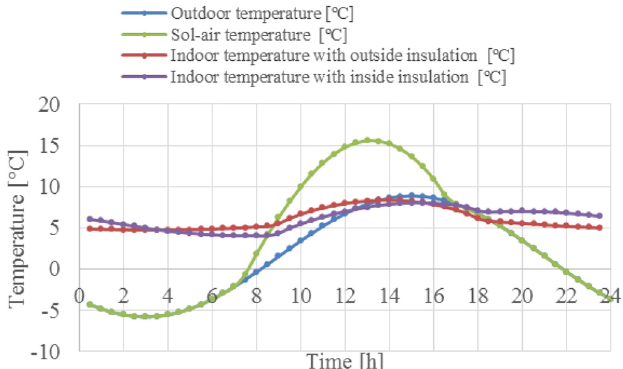
Fig. 11. Variation of the indoor temperature for walls with inside and outside insulation and taking into account the solar radiation through the window during a